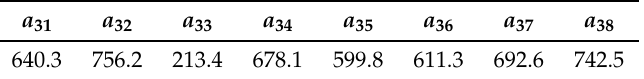
Table 3. Unit resource consumption coefficient (yuan/t).